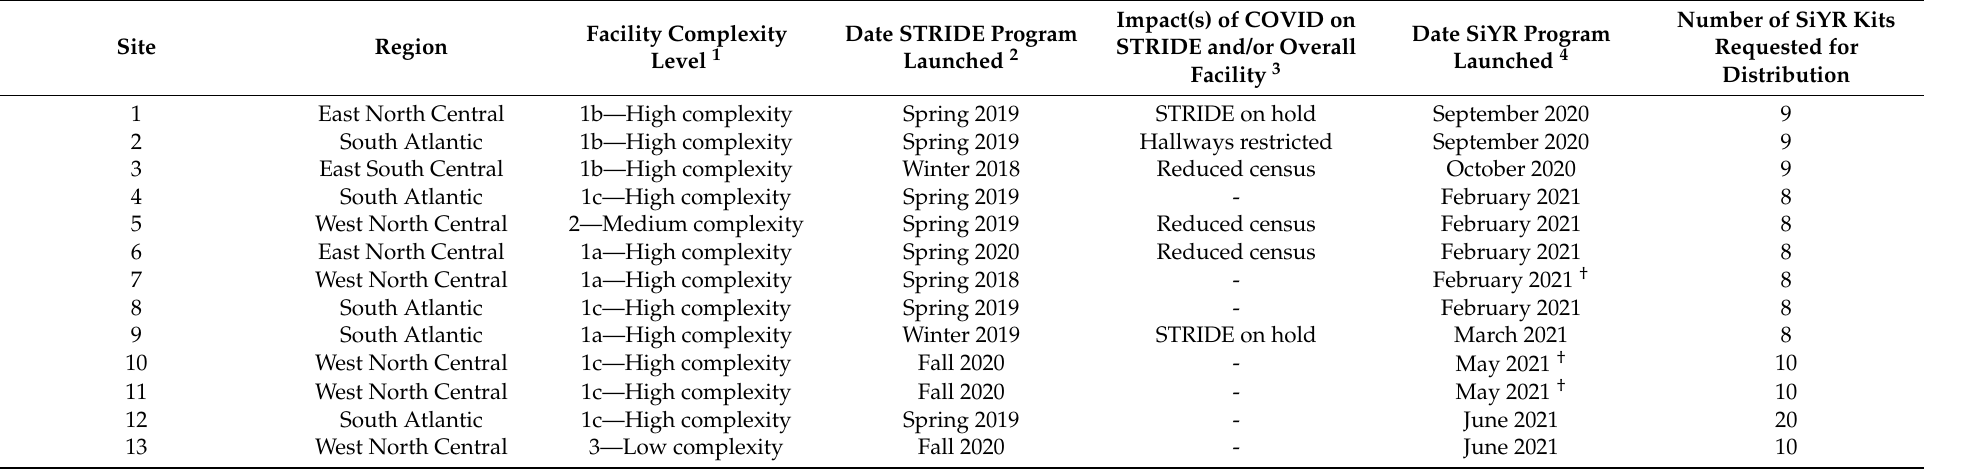
Table 3. Characteristics of sites participating in SiYR